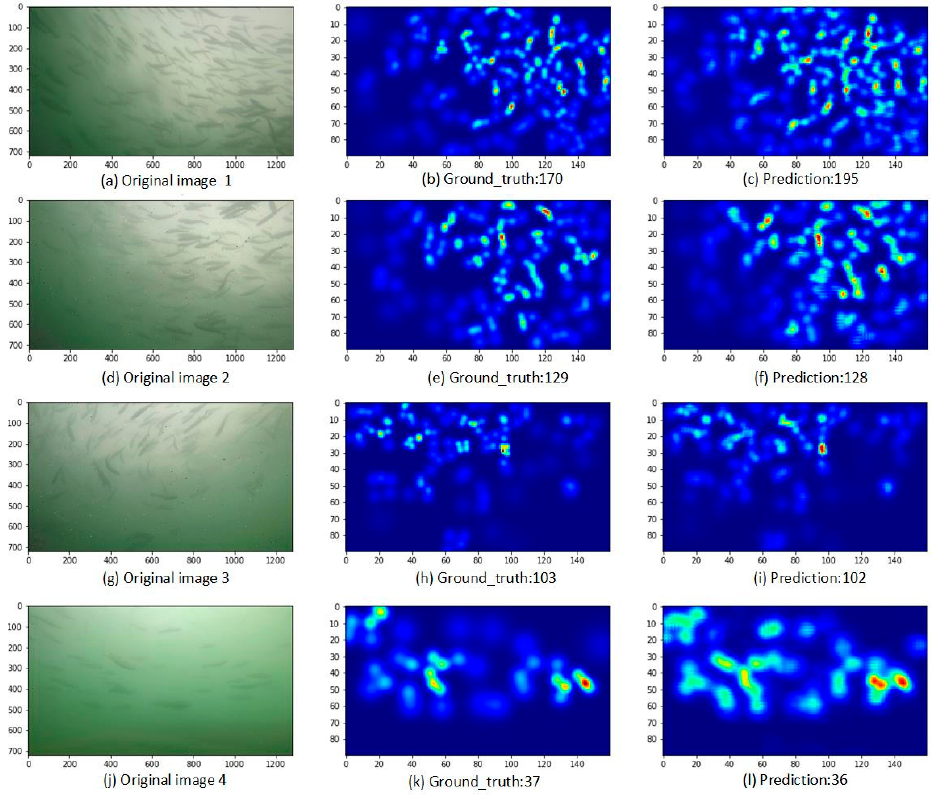
Figure 10. Fish counting results and density maps. ( a , d , g , j ) are original images; ( b , e , h , k ) are the